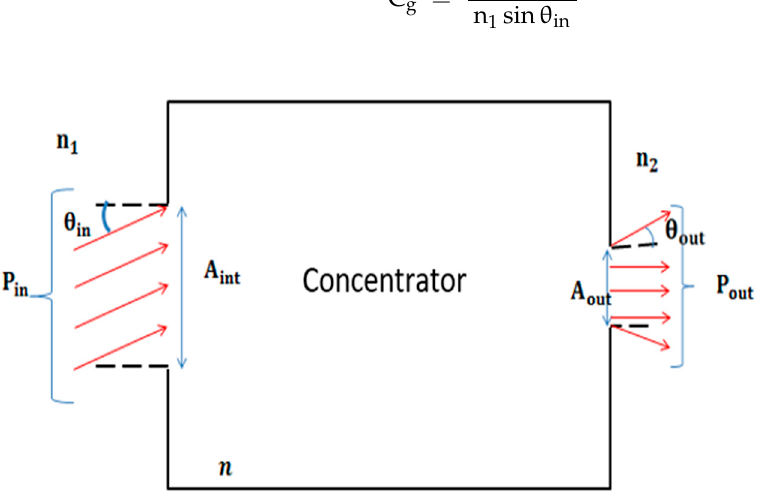
Figure 1. An optical system’s general view.